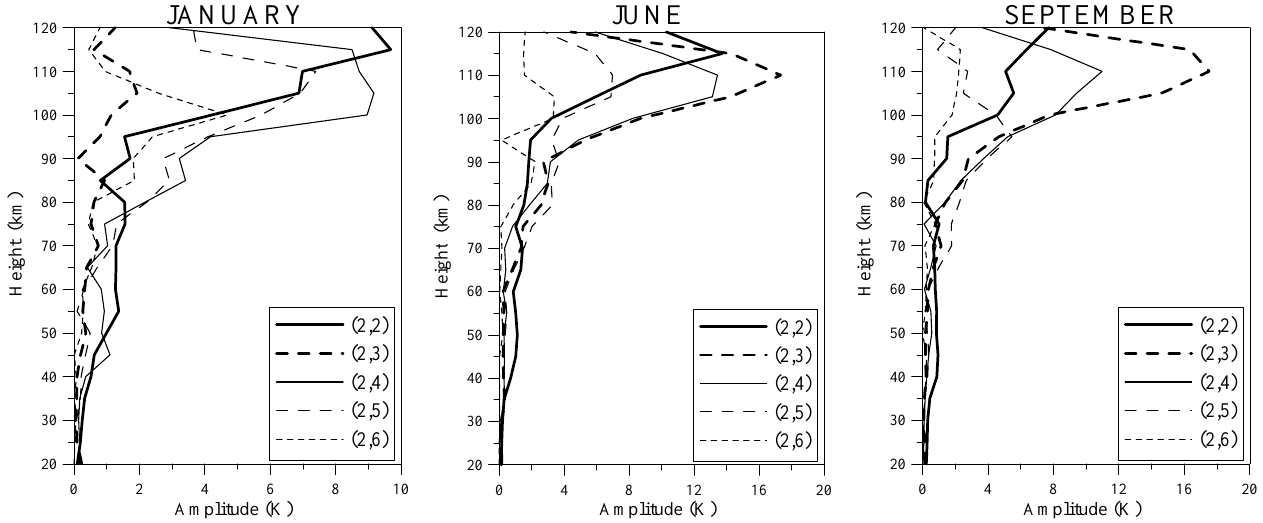
Figure 5 Fig. 5. The amplitude profiles of the Hough mode components for the SABER temperature SW2 tide obtained for January (left plot), June (middle plot) and September (right plot). The different Hough mode amplitudes are denoted by the following lines: (2,2) – tick solid; (2,3) – thick large dash; (2,4) – tin solid, (2,5) – thin large dash and (2,6) – thin small dash. The amplitudes of the Hough mode components of tem- perature for January (left plot), June (middle plot) and September (right plot) are shown in Fig. 5. The amplitude profiles are displayed for altitudes between 20 and 120